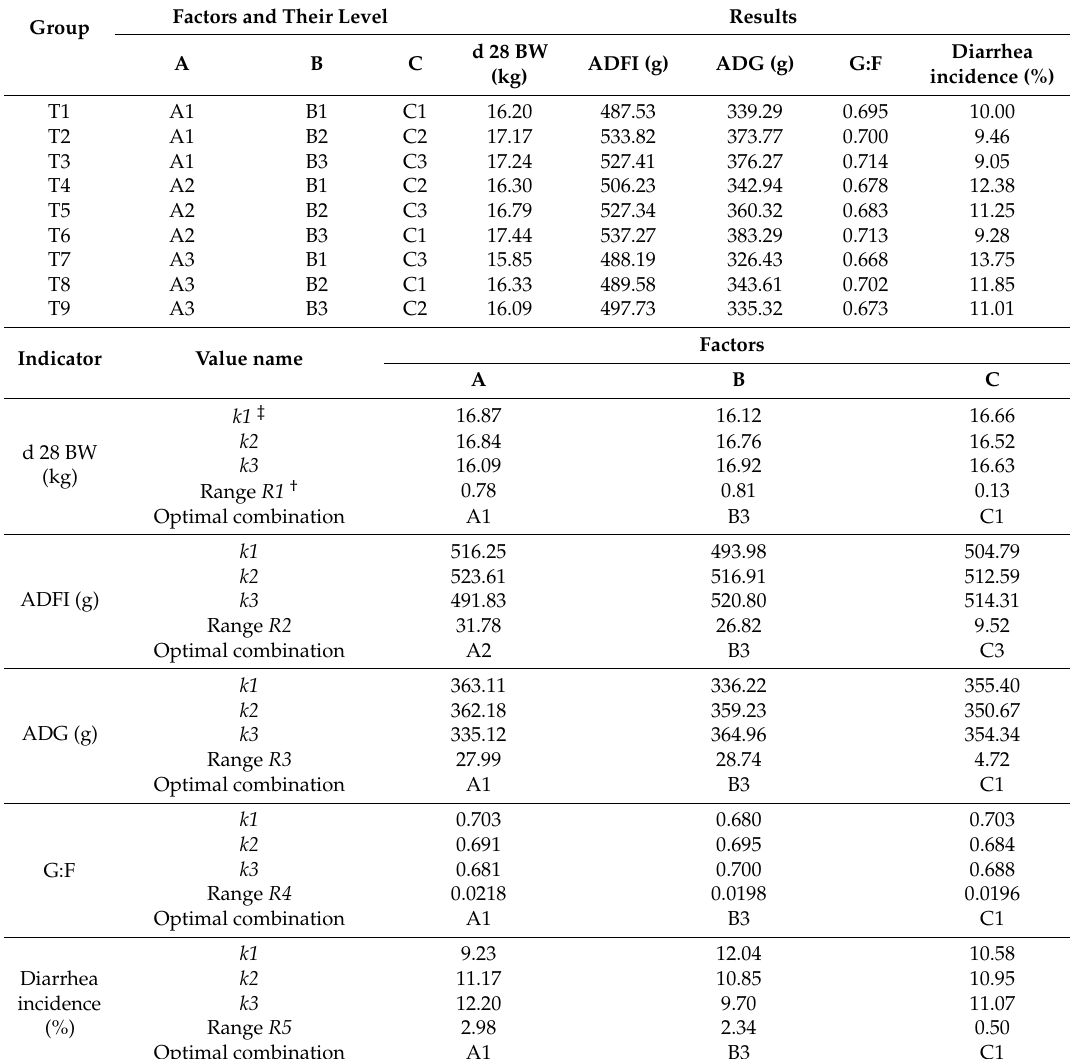
Table 5. The range analysis of the orthogonal